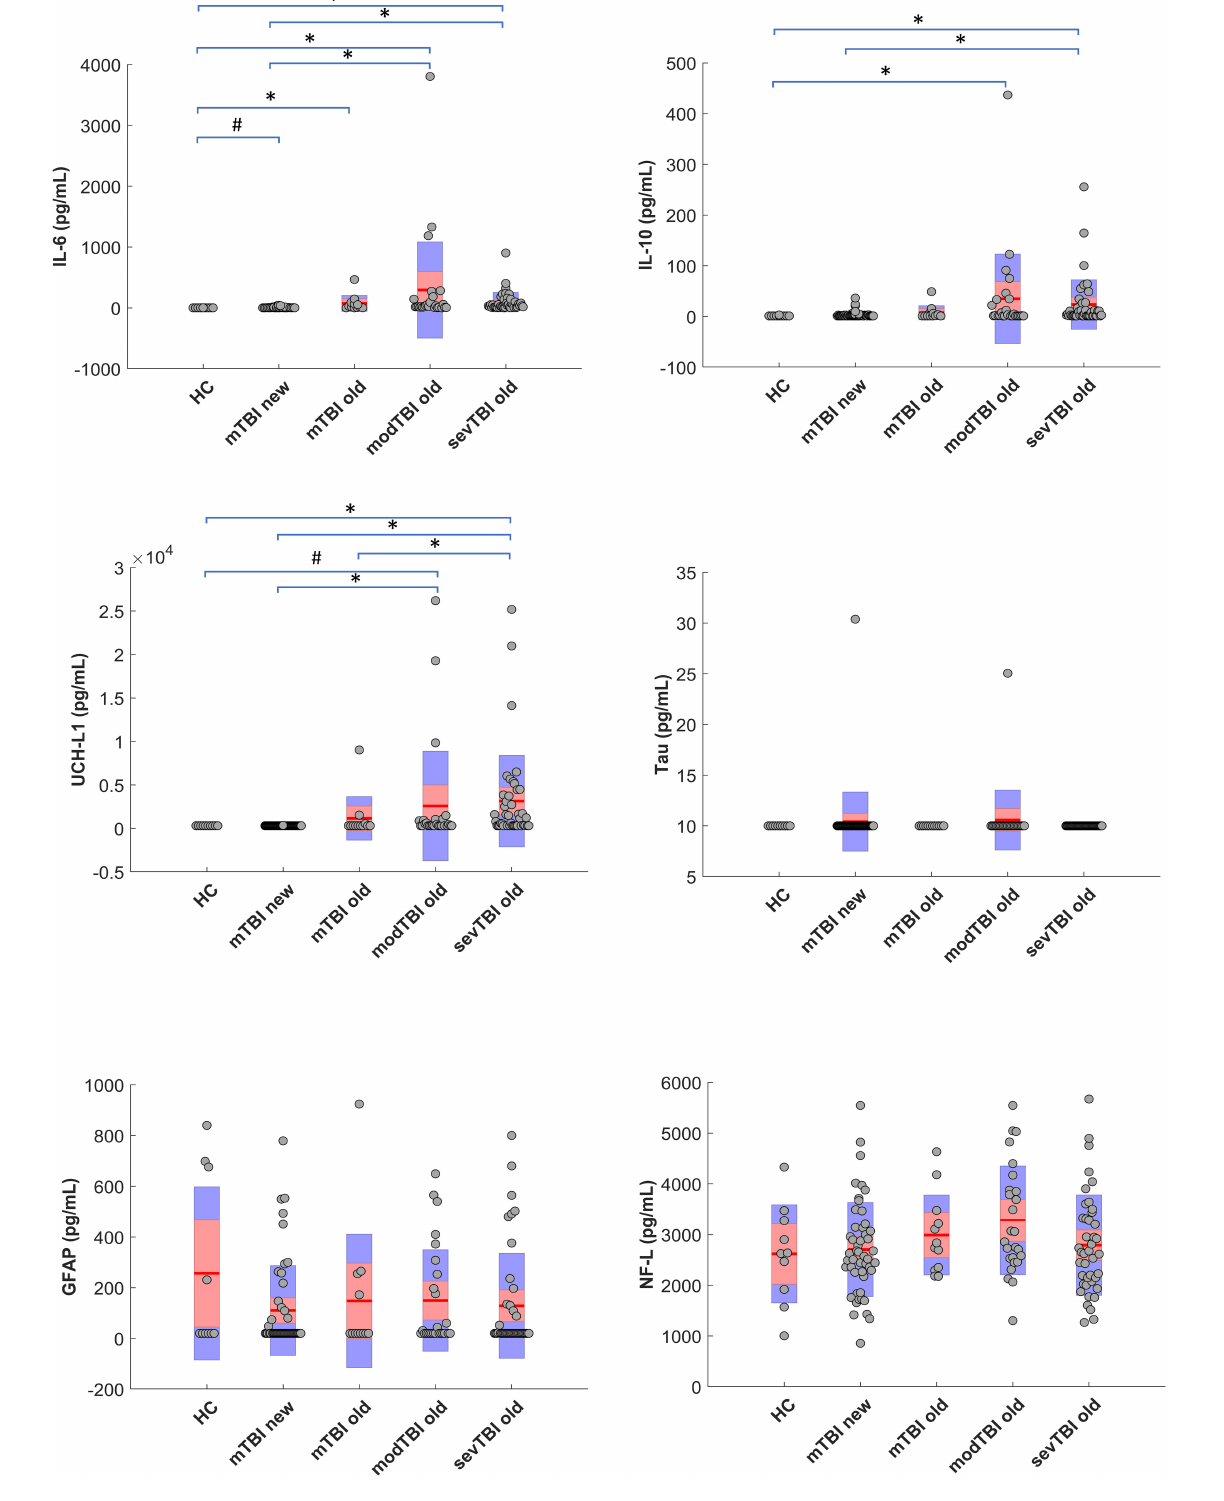
FIGURE 1 | Serum biomarker